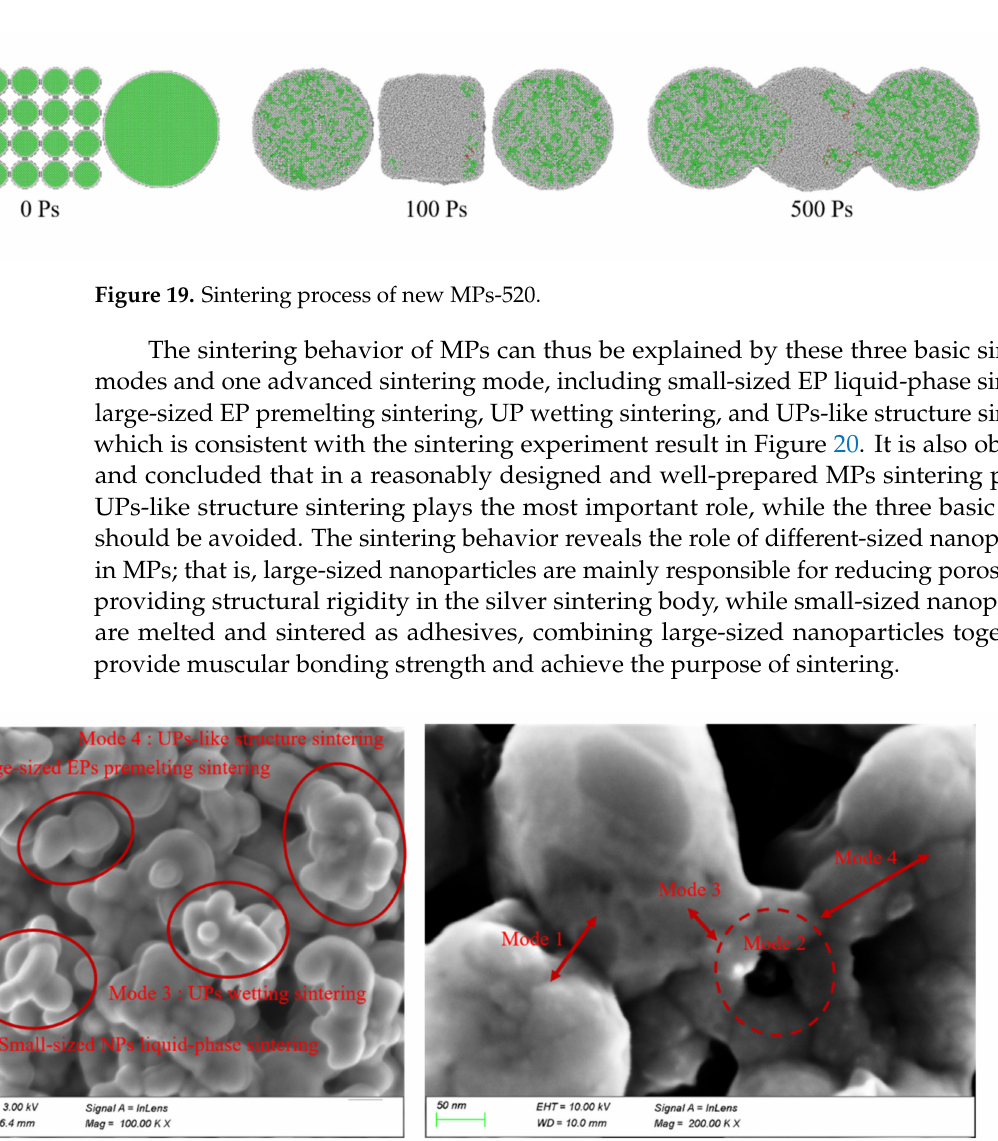
Figure 20. SEM image of the sintered MPs microstructure, which shows the three basic sintering modes and one advanced sintering